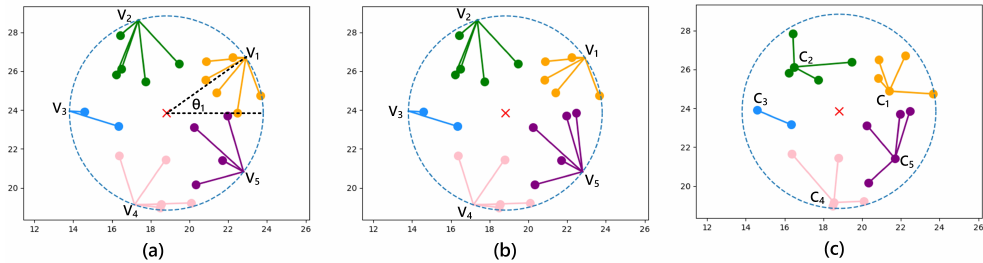
Figure 3. Dynamic clustering, ( a ) Initialization and promary clustering; ( b ) Fine adjustment; ( c ) Clus- ter head